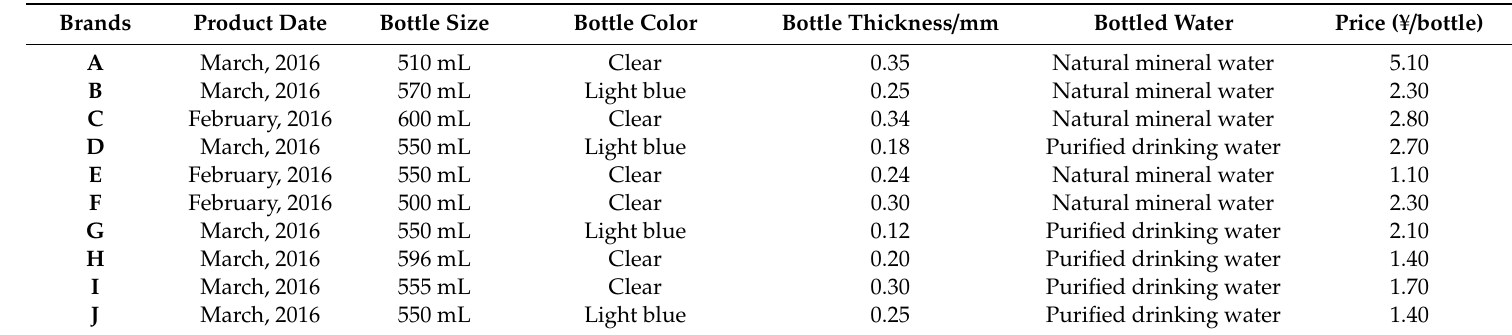
Table 1. Commercial Bottled Water Evaluated in the